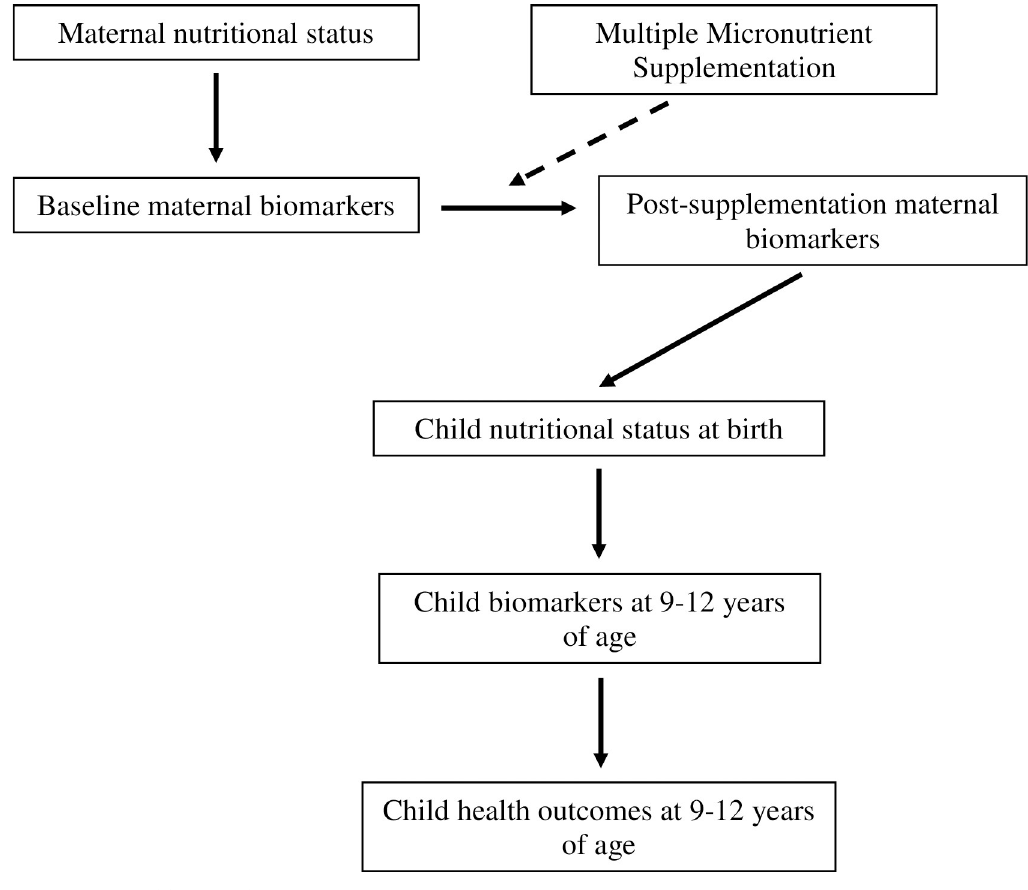
Fig 1. Conceptual